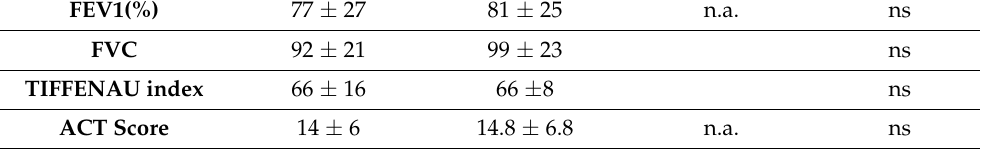
Table repots oral corticosteroid dosage expressed as prednisone equivalent. OCS: oral corticosteroids; ACT: asthma control test; ACQ: asthma control questionnaire. (n.a = not applicable, ns = not significant). Table 2. Comparison of clinical and functional